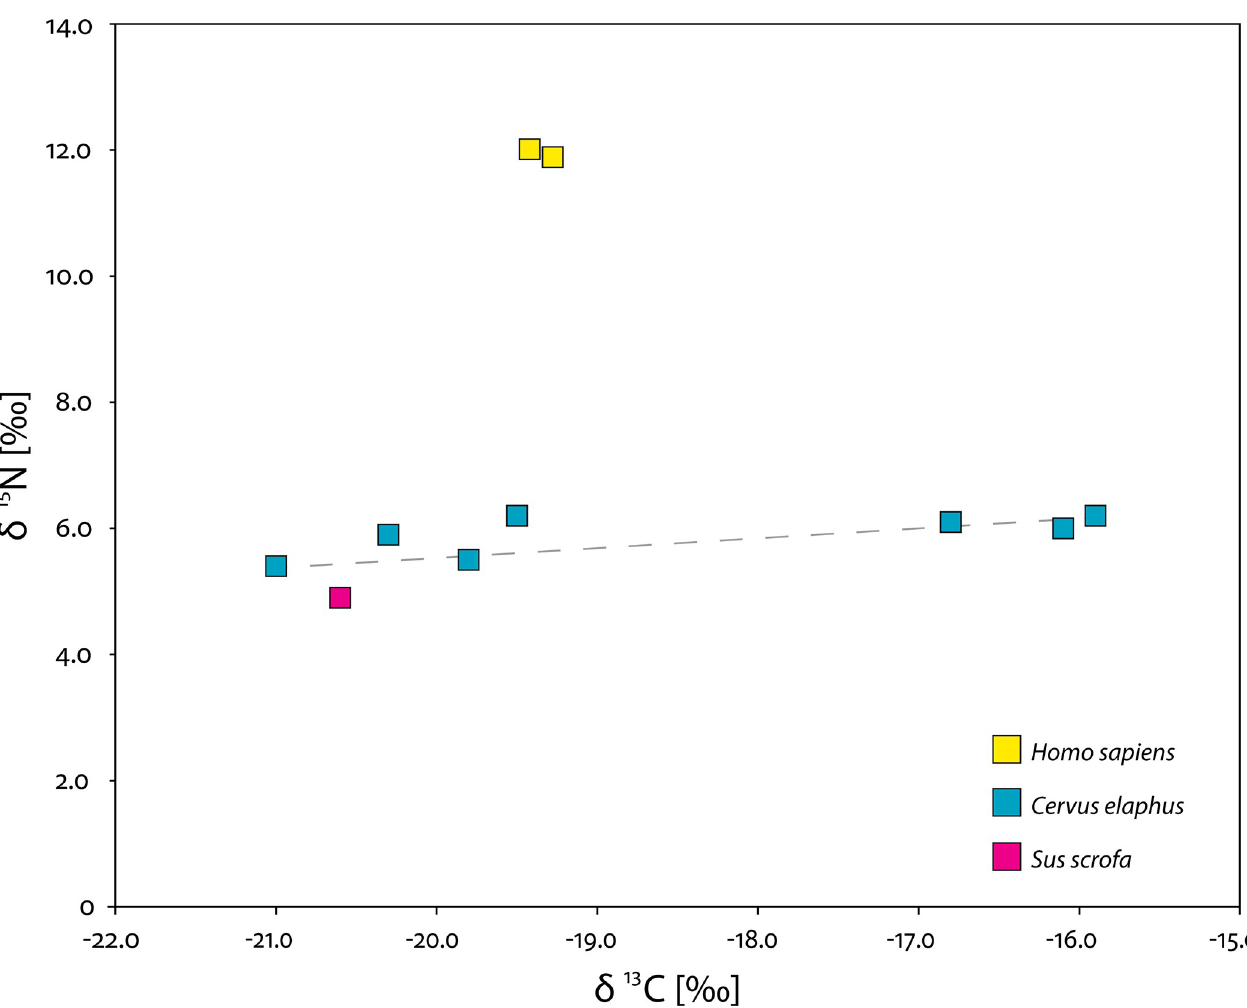
Fig 3. Isotope analyses. Carbon ( δ 13 C) and nitrogen ( δ 15 N) isotope composition of collagen extracted human and faunal remains recovered at Riparo di Fontana Nuova. The x-axis covers most of the variation in δ 13 C values recorded in Mediterranean contexts from fully terrestrial to marine